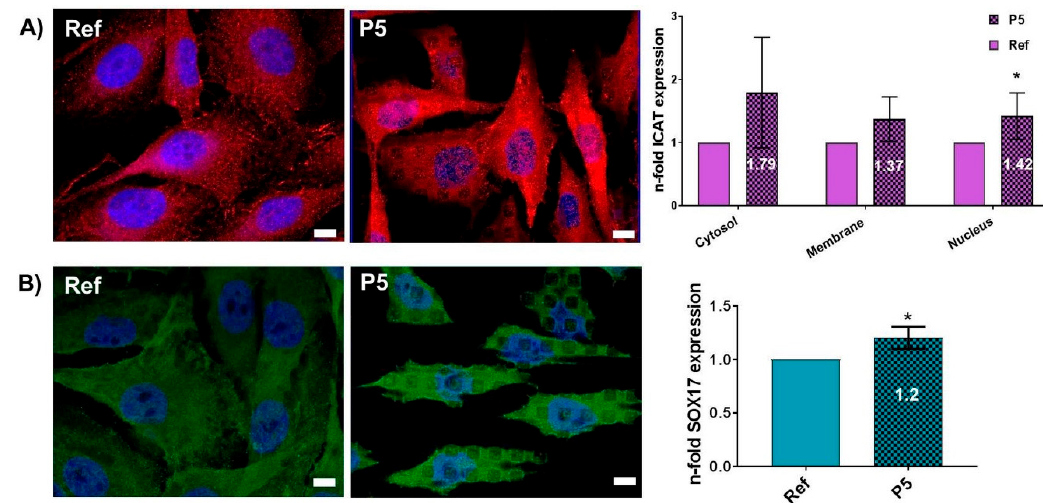
Figure 4. β -catenin inhibitors ICAT (inhibitor of β -catenin and TCF-4) and SOX17 (SRY-box transcription factor 17) in MG-63s on micro-pillars (P5) versus unstructured Ref after 24 h. ( A ) ICAT protein localization (red, Cy3-anti-ICAT; blue, nucleus, DAPI; LSM) and expression (ELISA). From the LSM images it is visible that on Ref the MG-63s showed a homogeneous distribution of ICAT over the entire cell. On P5 the ICAT protein appears concentrated in the nucleus (see also Figure S5). The quantification of this protein in subcellular fractions confirmed a significantly increased ICAT level in the nucleus on P5. (ELISA; Ref values normalized to 1; mean ± s.e.m.; 3 independent experiments; multiple t -test; * p < 0.05). ( B ) SOX17 protein localization (green, Alexa Fluor ® 488-anti-SOX17; blue, nucleus, DAPI) and expression (flow cytometry). Note the increased SOX17 in MG-63s on P5 observed both in immunofluorescence and flow cytometry. (FACSCalibur; Ref values normalized to 1; mean ± s.e.m. of 5 independent experiments; Mann-Whitney U-test; * p < 0.05). All immunofluorescence images by LSM 780; 63 × , P5 image as 3D confocal z-stack overlay, scale bar: 10 µ